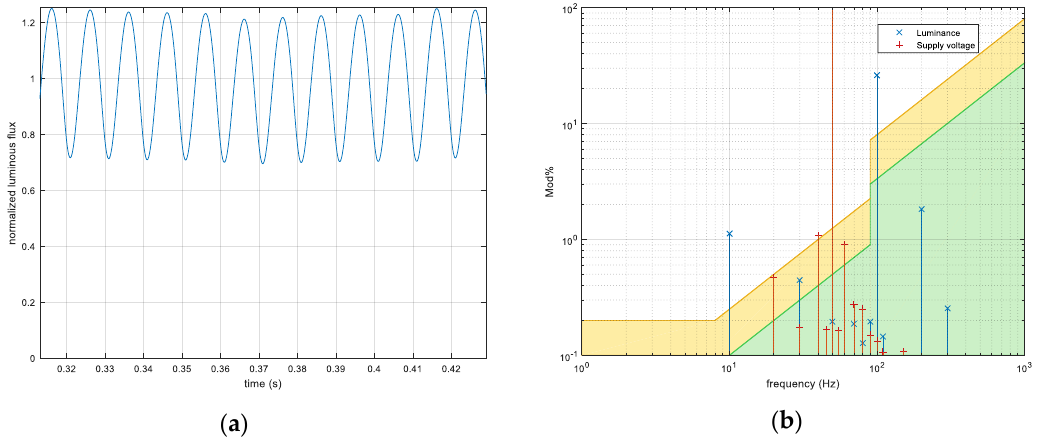
Figure 2. ( a ) Normalized luminous flux as a function of time of a 42 W LED luminaire with a factory driver. Supply voltage is modulated with a rectangular pulse of 100 ms and 1% amplitude and ( b ) Harmonic composition of luminous flux and supply voltage.